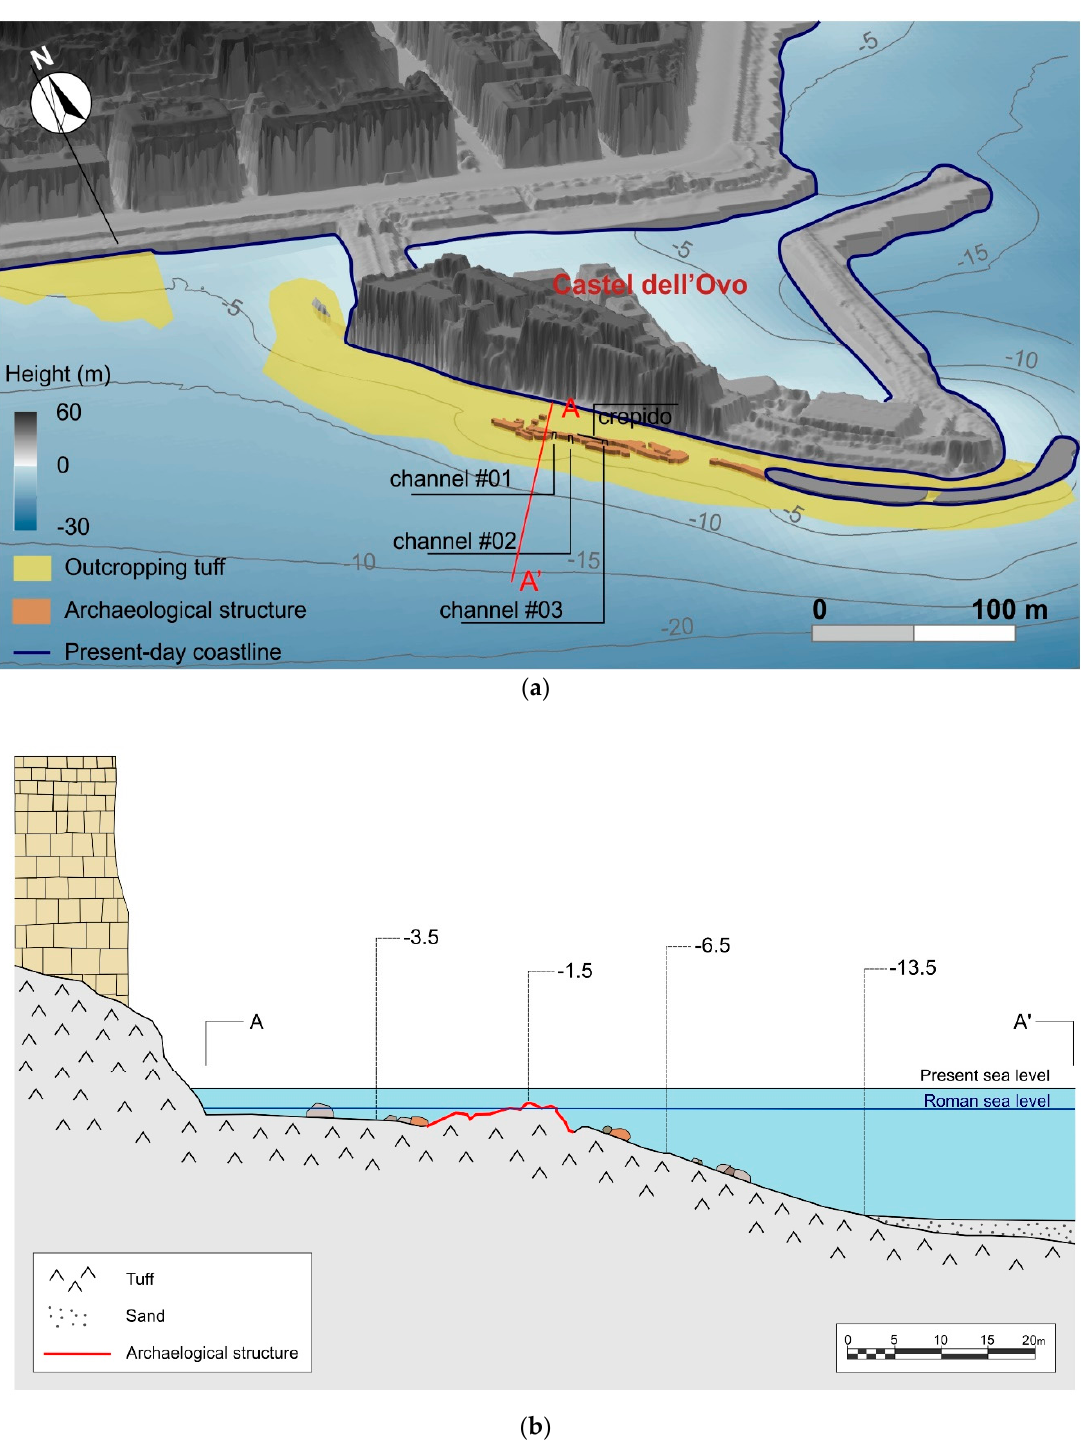
Figure 16. 3D reconstruction of the ( a ) emerged submerged landscape and with archaeological structure studied here. The DSM in Figure (with a grid 1 × 1 m) was provided by the Municipality of Naples. ( b ) Onshore-offshore schematic profile crossing the main archaeological structure sculptured in tuff, for position see ( a ) of this figure.